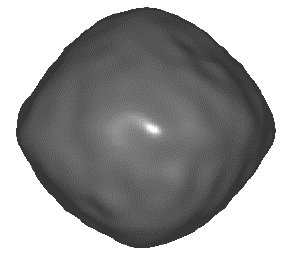
Figure 5. Bennu’s reconstructed asteroid surface.